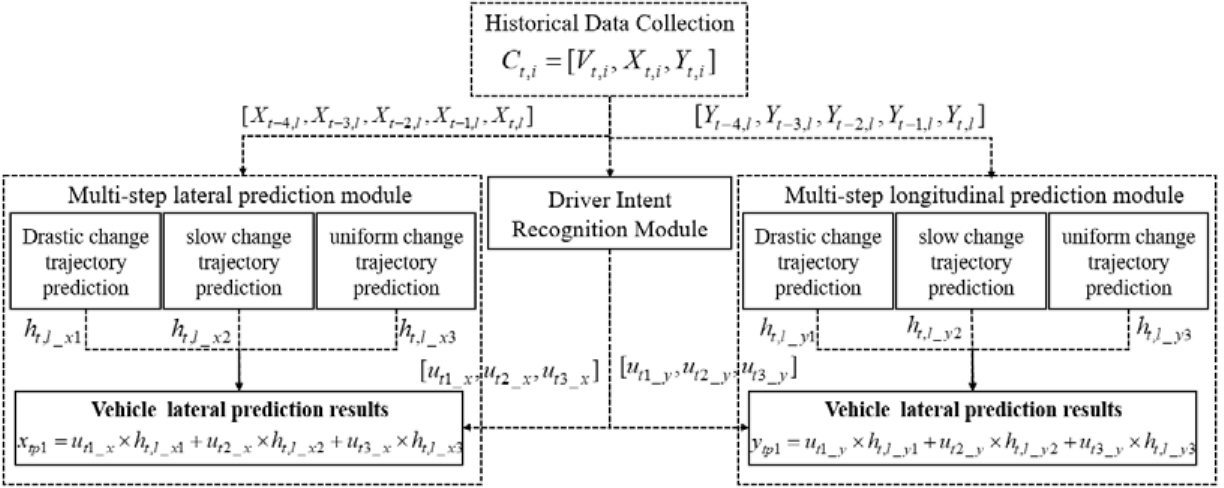
Figure 2. The structure of the algorithm for trajectory prediction for 1-step.